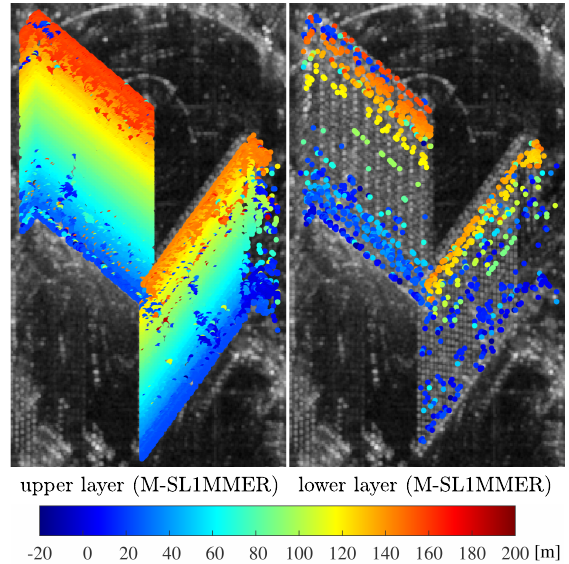
Figure 9. Elevation estimates of two test buildings with M-SL1MMER using 6 TanDEM-X bistatic sliding spotlight interferograms. In the case of layover, the higher and lower scatterers appear in the upper and lower layers, respectively